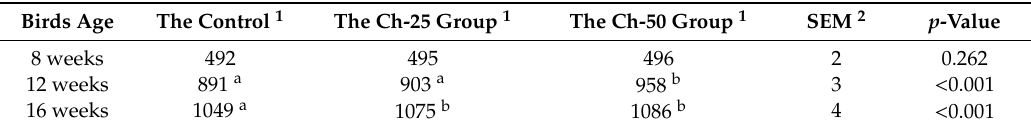
Table 2. Body weights (g) of male